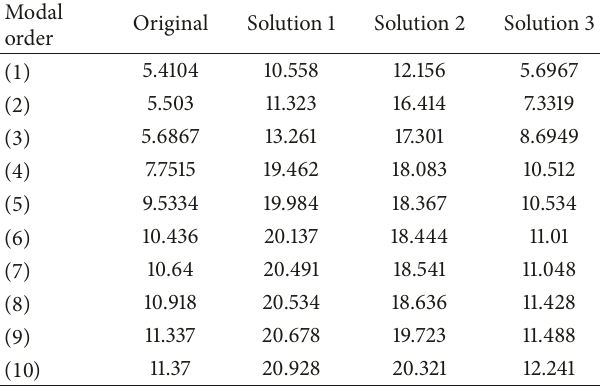
Table 8: Natural frequencies of original and new